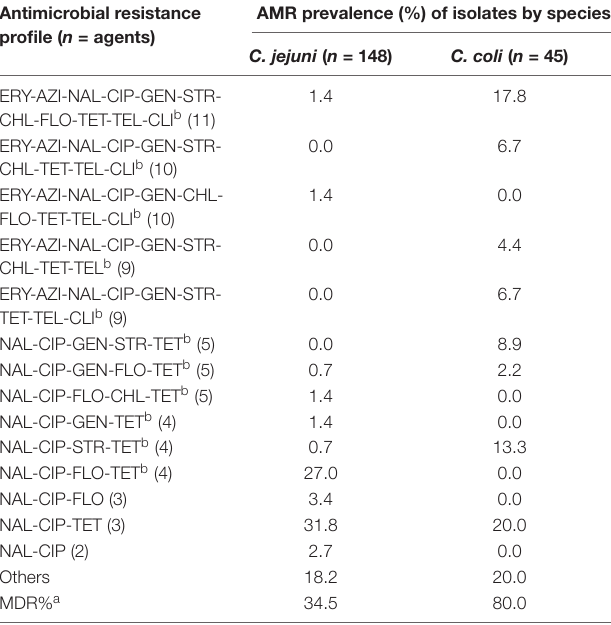
TABLE 3 | Major antimicrobial resistance patterns of C. jejuni and C. coli . Antimicrobial resistance AMR prevalence (%) of isolates by profile ( n = agents)